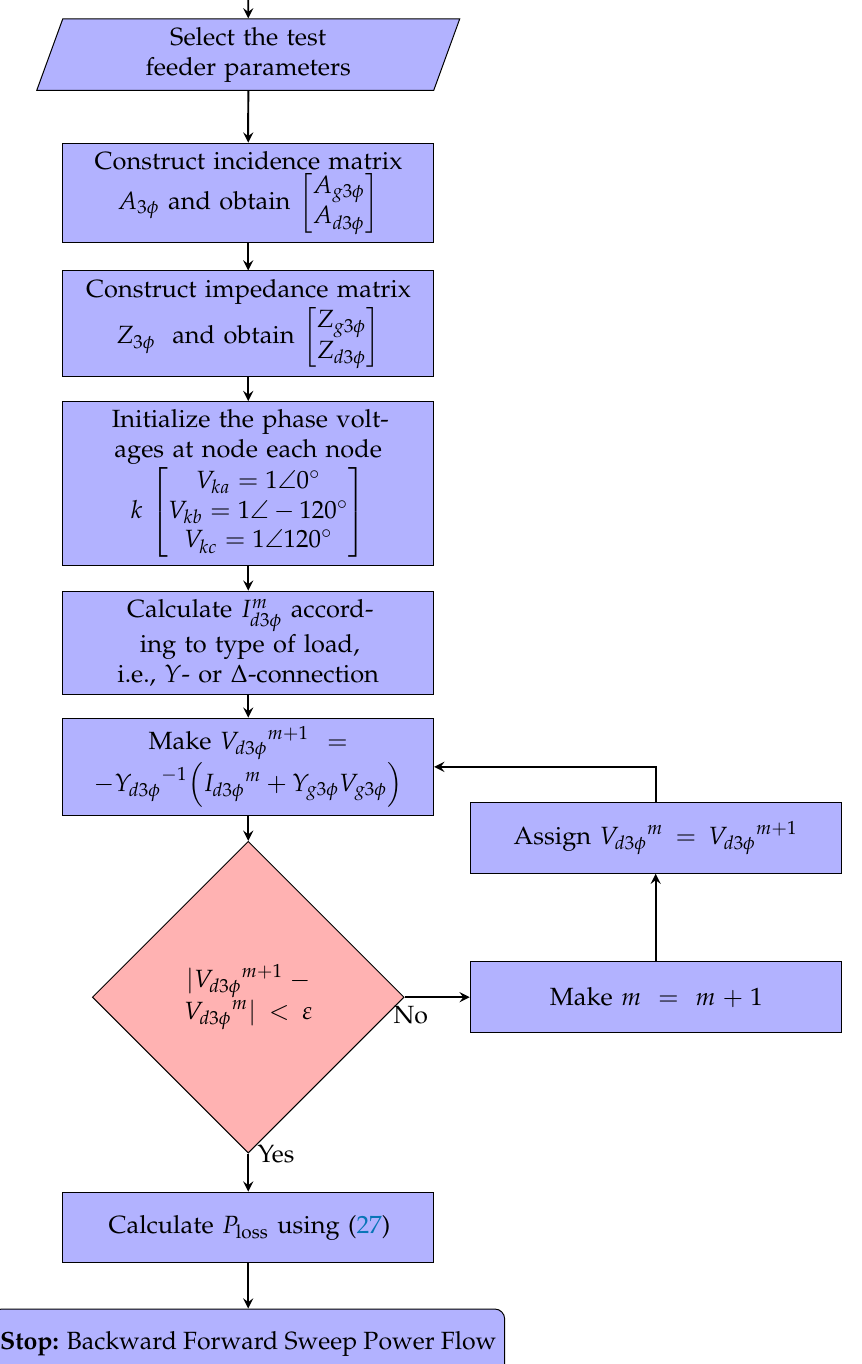
Figure 3. Flowchart for three-phase backward/forward power flow. The solution of the three-phase power flow problem using the backward/forward approach for the numerical example is reported in Table 3, which also compared the results with those obtained using the Newton-Raphson method available in the DigSILENT soft-